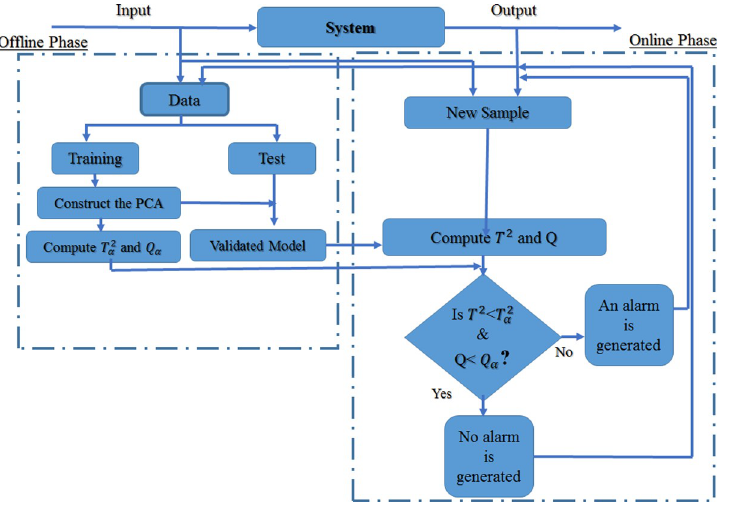
Fig 2. Flowchart of static PCA